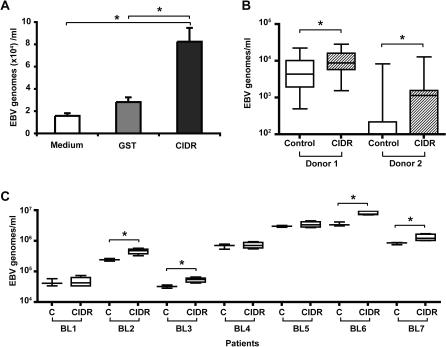
Stimulation of Tonsil B Cells and PBMCs from EBV-Positive Donors and BL Patients with CIDR1α Increases the EBV Load(A) Tonsil B cells were cultured in medium alone (white bar), with GST (1 μM) (light grey bar), and with CIDR1α (1 μM) (dark grey bar). After 48 h of incubation, the viral genome copy number in the cultures was determined by real-time PCR. *, p = 0,04.(B) PBMCs from two EBV-positive healthy donors were cultured with GST (1 μM) (white bars) and with CIDR1α (1 μM) (dashed bars). After 48 h of incubation, the viral genome copy number in the cultures was determined by real-time PCR. Data are expressed as EBV copies/mL. Vertical bars depict median values, with 25th and 75th percentile values represented by the bottom and top edges of the bar. Each bar shows the EBV load from one patient measured in multiple replicates and in three independent experiments. *, p
Donor1 = 0,04; *, p
Donor2 = 0,001.(C) PBMCs from children with BL were cultured with medium or GST (1 μM), our internal controls (C), and with CIDR1α (1 μM). After 48 h of incubation, the viral genome copy number in the cultures was determined by real-time PCR. Data are expressed as EBV copies/mL. Vertical bars depict median values, with 25th and 75th percentile values represented by the bottom and top edges of the bar. Each bar shows the EBV load measured in multiple replicates. *, p
BL2 = 0,01; *, p
BL3 = 0,01; *, p
BL6 = 0,0003; *, p
BL7 = 0,03.